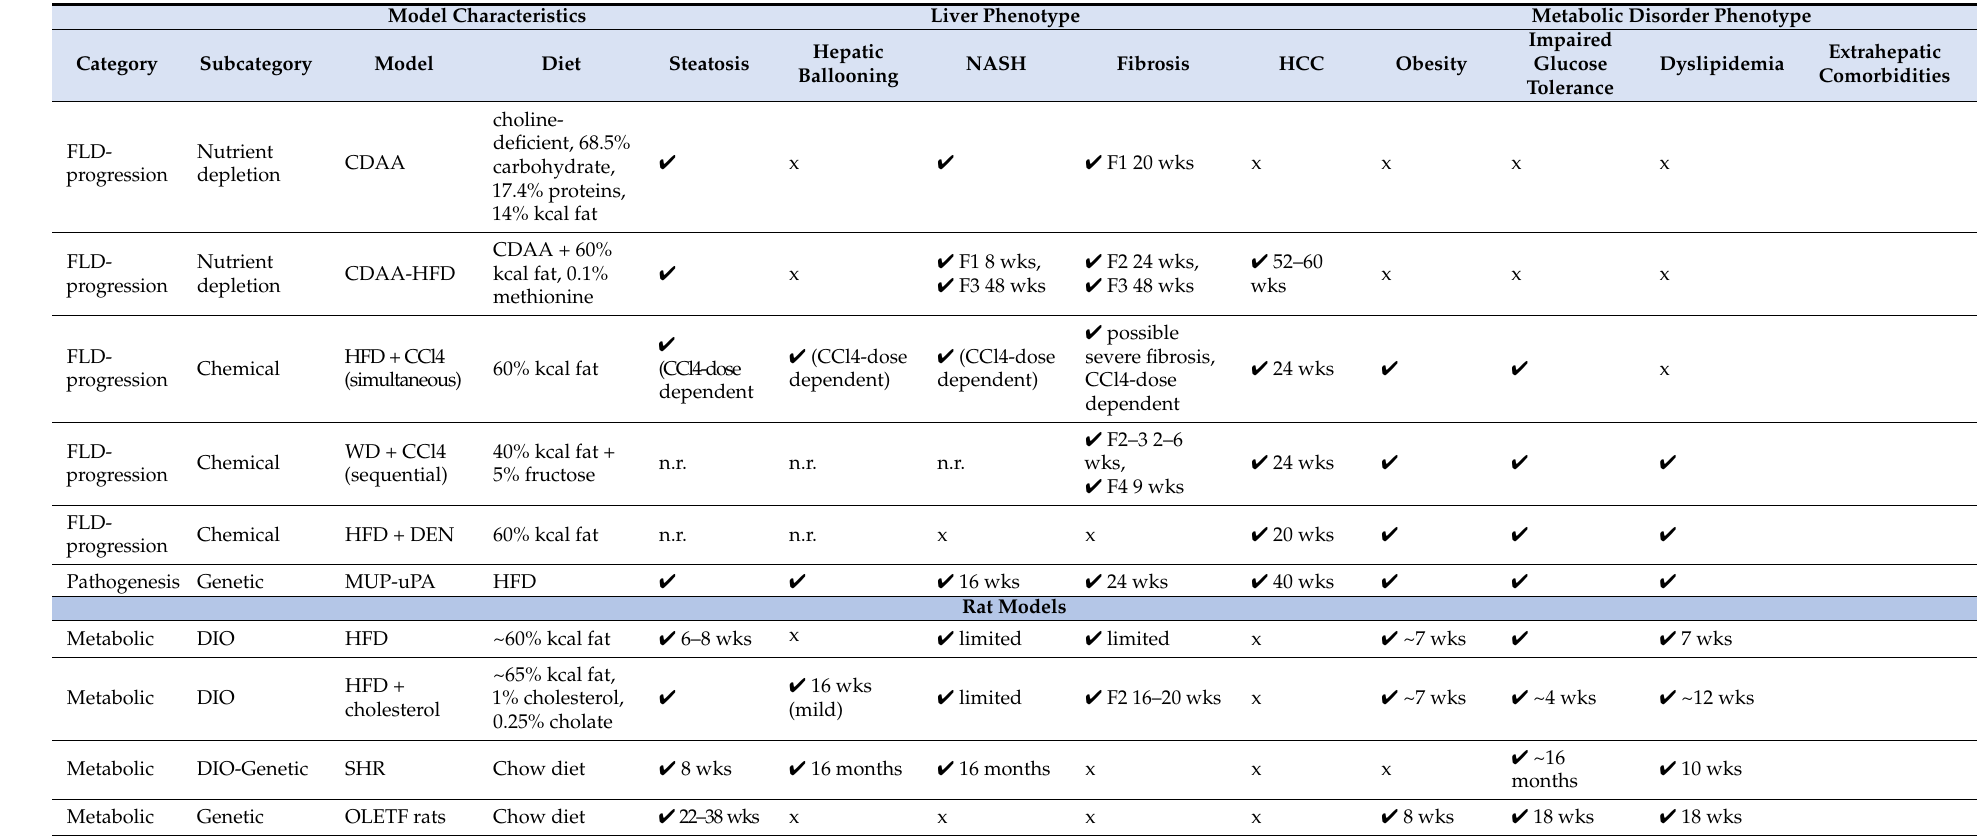
Table 1. Cont. Model